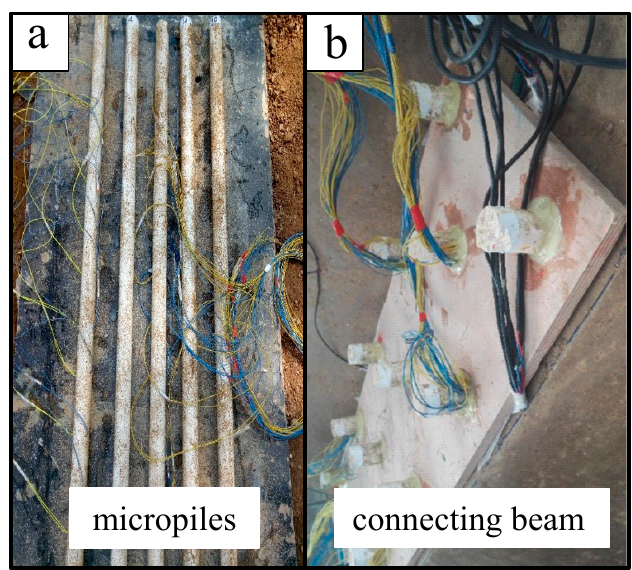
Figure 4. Models of the ( a ) micropiles and ( b ) connecting beam.